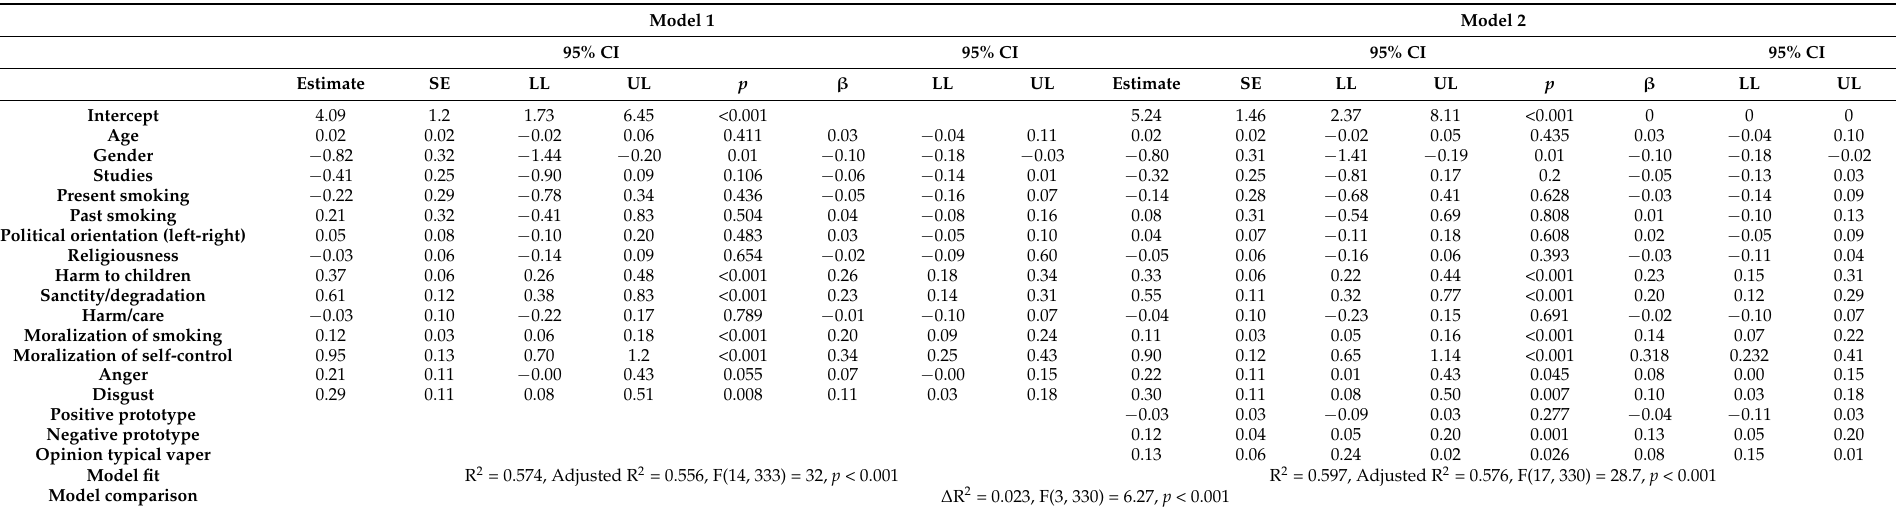
Table 3. Results of hierarchical regression analyses: Predictors of moralization of